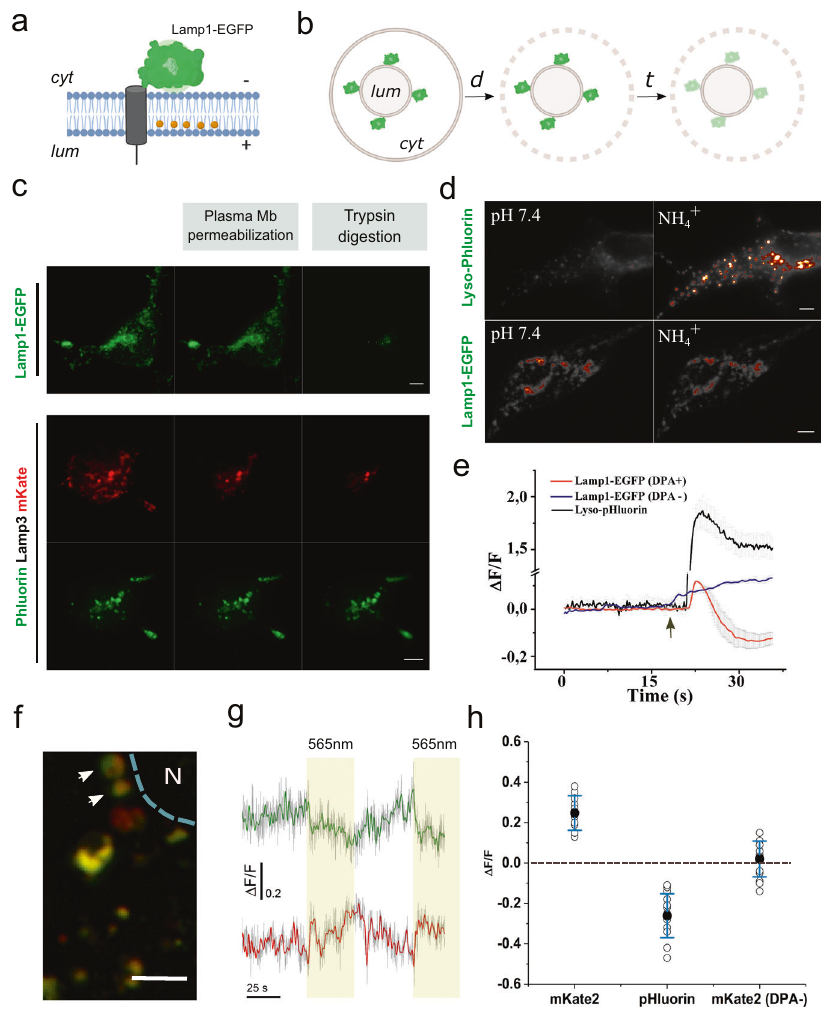
Fig. 3 Topology of Lamp1-EGFP and the effect of lysosomal pH on hVoS org signals. a Cartoon of the predicted topology of the FRET pair with EGFP facing the cytoplasm and DPA accumulated at the luminal lea fl et of the lysosomal membrane. b Schematic representation of the FPP assay illustrating the position of the fl uorescent tags relative the organelle membrane. A 2-min treatment with 10 μ M digitonin (d) is followed by perfusion with ringer containing 4 mM trypsin (t). c Lamp1-EGFP exposes the fl uorescent protein to the cytoplasm as revealed by protease protection assay (top) (scale bar, 5 μ m). Representative image of HEK-293T cells expressing lyso-pHoenix (pHluorin-CD63-pHluorin-Arch3-mKate) were subjected to the FPP assay (bottom panels) (scale bar, 5 μ m). d Representative images of HEK293 cells expressing the pH sensor pHluorin (top) or EGFP (bottom). Images were taken before (left) and after (right) ammonium treatment. e Time course of fractional fl uorescence during ammonium treatments. The arrow denotes addition of NH4 + . f Representative image of individual lysosomes expressing Lyso-pHoenix. Arrows indicate representative individual lysosomes. N indicates the position of the nucleus. (scale bar, 3 μ m). g Traces of pH signal (green shades) and membrane voltage signal (red shades) acquired in response to light stimulation (indicated in yellow). Traces were obtained by averaging the response of the lysosomes indicated in f . Solid lines correspond to the smoothened signal. h Average values of Δ F/F for the change in membrane voltage (mKate2), luminal pH (pHluorin) ( n = 5 independent paired experiments), and the voltage-insensitive mKate2 in the absence of the voltage sensor DPA ( n = 3 independent experiments). Error bars indicate mean